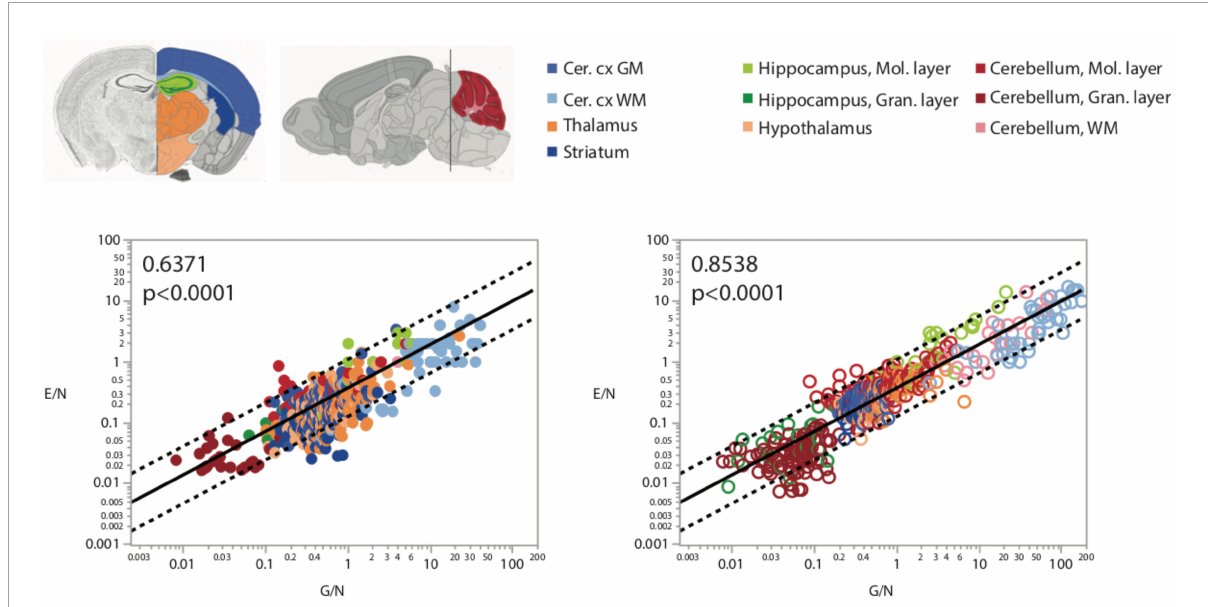
FIGURE8 More endothelial cells per neuron (E/N) are uniformly found in brain structures and sites with more glial cells per neuron, as expected given that both these variables are strongly and inversely correlated with local neuronal density ( Figures 2 , 3 ). Spearman correlation coefficients are indicated in the